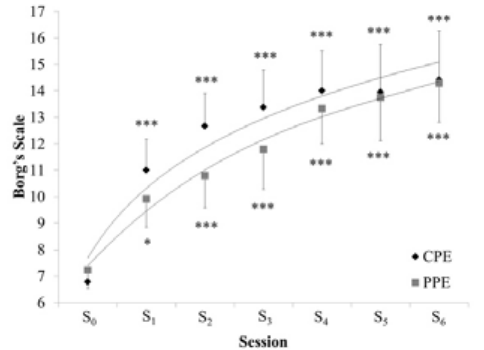
Figure 5. Central (CPE) and peripheral (PPE) perceived exertion rating recorded after each badminton session. Values are mean and standard deviation. A significant difference at the post hoc test with S 0 is indicated by *: P < 0.05; **: P < 0.01; ***: P < 0.001. A polynomial function is used for each R 2